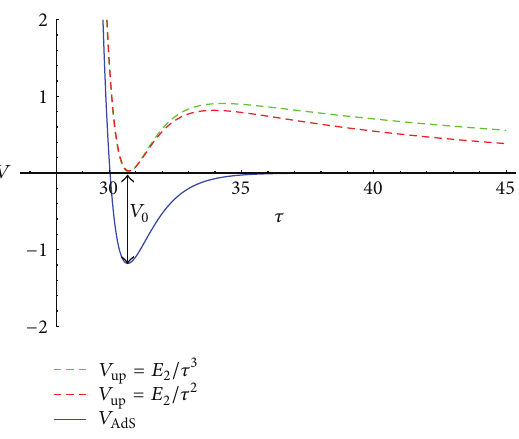
Figure 1: The scalar potential 𝑉(𝜏) (multiplied by 10 29 ) with 𝑊 0 = −10 −12 , 𝐴 = 1 , and 𝑎 = 1 . The blue curve shows the AdS minimum, while the green and red curves exhibit the uplifting to dS minimum via 𝛿𝑉 = 𝐸 3 /𝜏 3 , 𝐸 2 /𝜏 2 , respectively, with 𝐸 3 = 3.5 × 10 −25 and 𝐸 2 = 1.13 × 10 −26